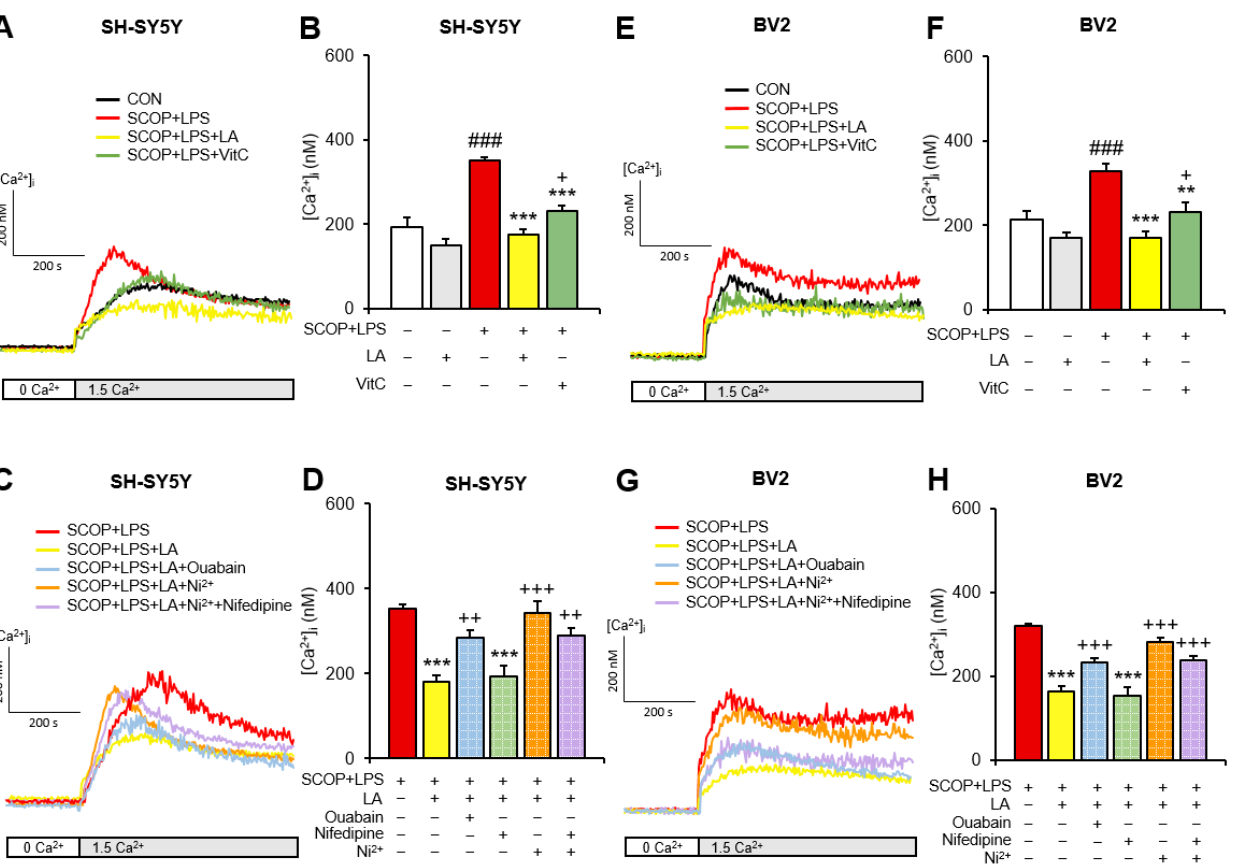
Figure 2. Effects of linalyl acetate (LA) on store-operated Ca 2+ entry (SOCE) in SH-SY5Y and BV2 cells pretreated with scopolamine (SCOP) and treated with lipopolysaccharide (LPS) and the hypothesized mechanism underlying the LA-induced reduction in SOCE in LPS-exposed, SCOP- pretreated SH-SY5Y and BV2 cells. Representative traces showing the effects of LA on SOCE in scopolamine-pretreated and LPS-exposed ( A ) SH-SY5Y and ( E ) BV2 cells. Summary data showing the peak [Ca 2+ ] i observed after the addition of 1.5 mM Ca 2+ in ( B ) SH-SY5Y and ( F ) BV2 cells. Representative traces showing the effect of ouabain, Ni 2+ , or nifedipine on the LA-induced decreases in SOCE of LPS-exposed, SCOP-pretreated ( C ) SH-SY5Y and ( G ) BV2 cells. Summary data showing the peak [Ca 2+ ] i after adding 1.5 mM Ca 2+ in ( D ) SH-SY5Y and ( H ) BV2 cells. Data are reported as means ± SEM ( n = 5–9; ### p < 0.001 vs. the control (CON) group; ** p < 0.01, *** p < 0.001 vs. the SCOP+LPS group; + p < 0.05, ++ p < 0.01, +++ p < 0.001 vs. the SCOP + LPS + LA group).